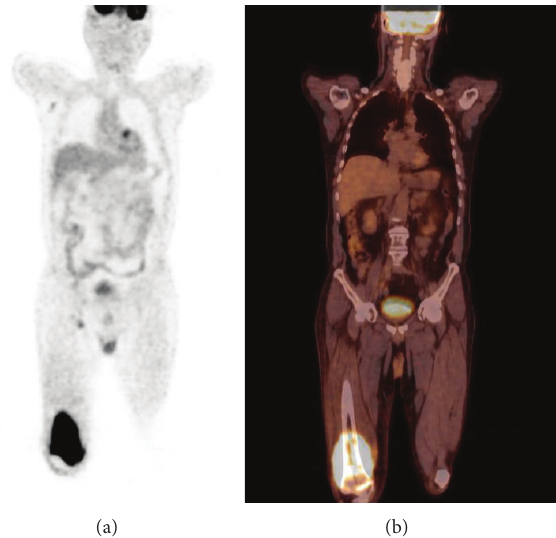
Figure1:Hypermetaboliclesion,whichbeginsfromthemiddlepart of the right femur and invaded the muscular tissue, as well as the bone tissue and bone marrow in the distal diaphysis of the femur, is observed on the PET (a) and fusion (b) images of the patient (SUVmax = 16.1).